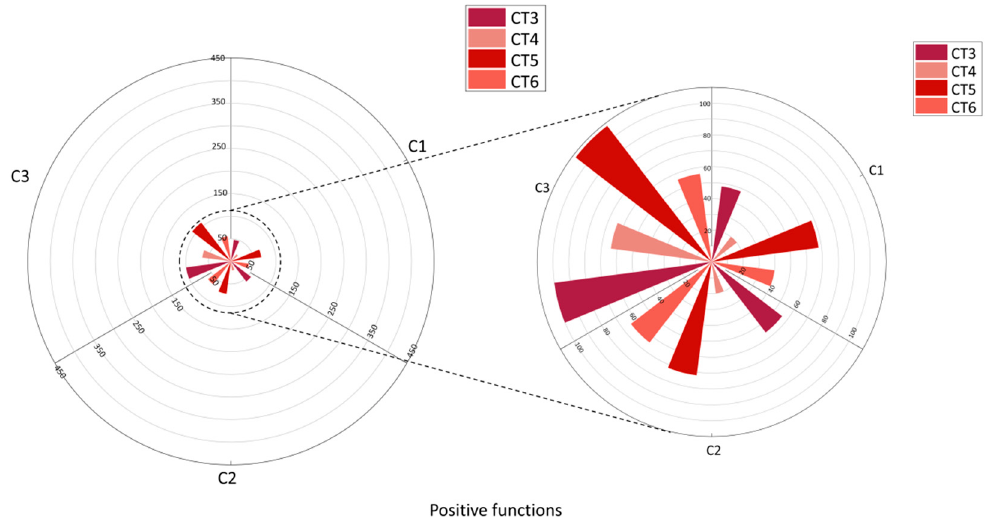
Figure 7. Distribution of the characteristics of positive RCC functions by cause. Source: Authors.